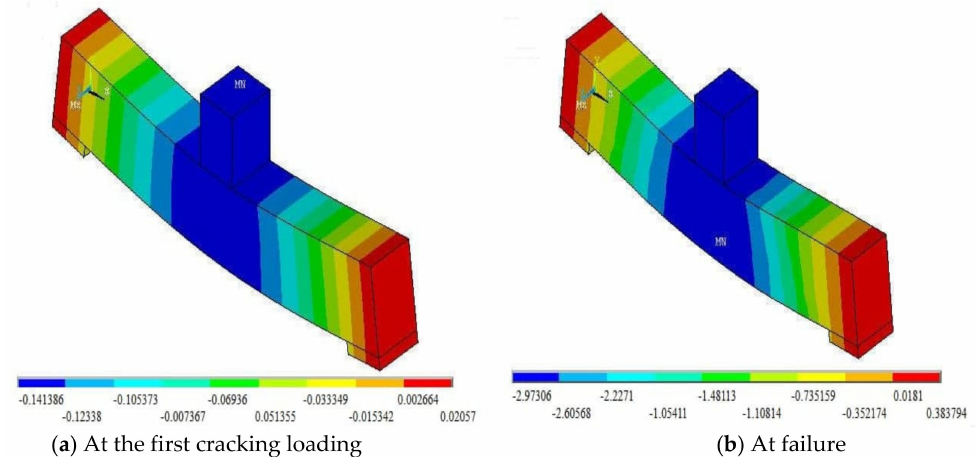
Figure 9. 3D deflection contours of the control beam model B1 at different loading stages.